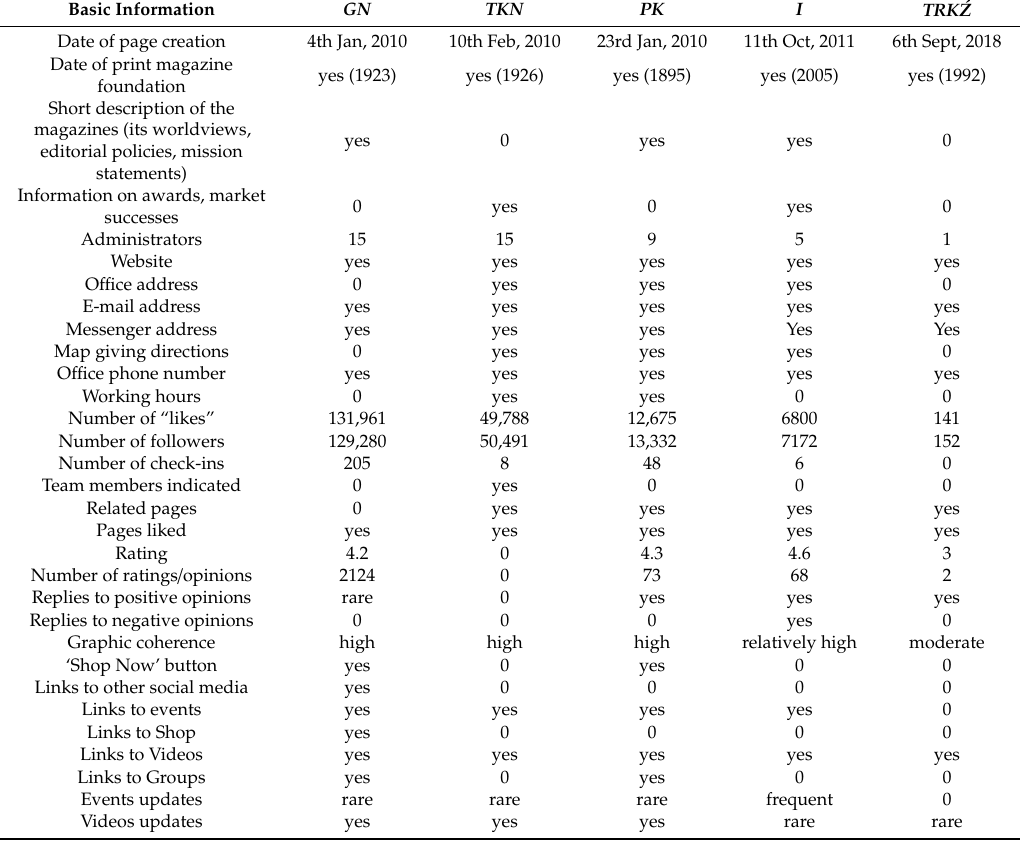
Table 3. Comparison of the profiles—analysis results (for the 24th February